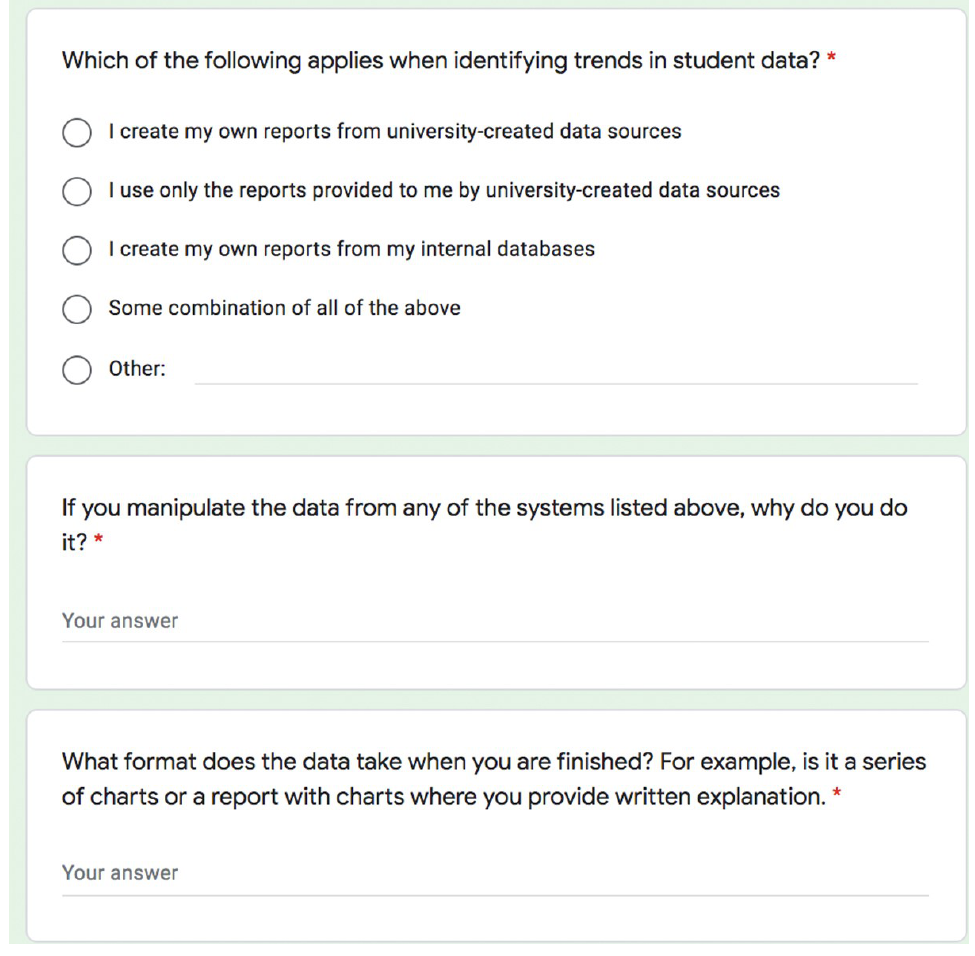
Figure 3. A screenshot of some of the survey questions administered to end users across five colleges and universities. * denotes required